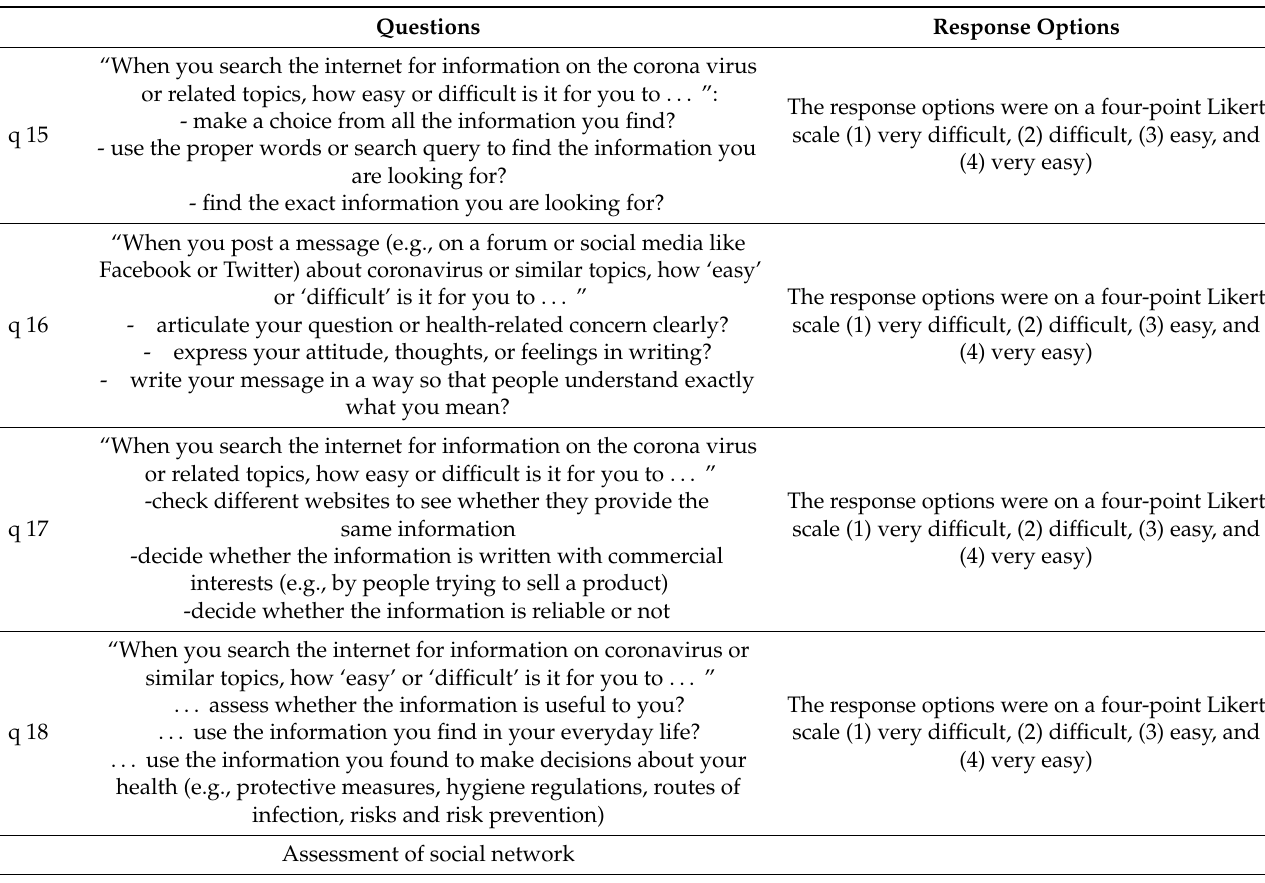
Table 1. Questions and response